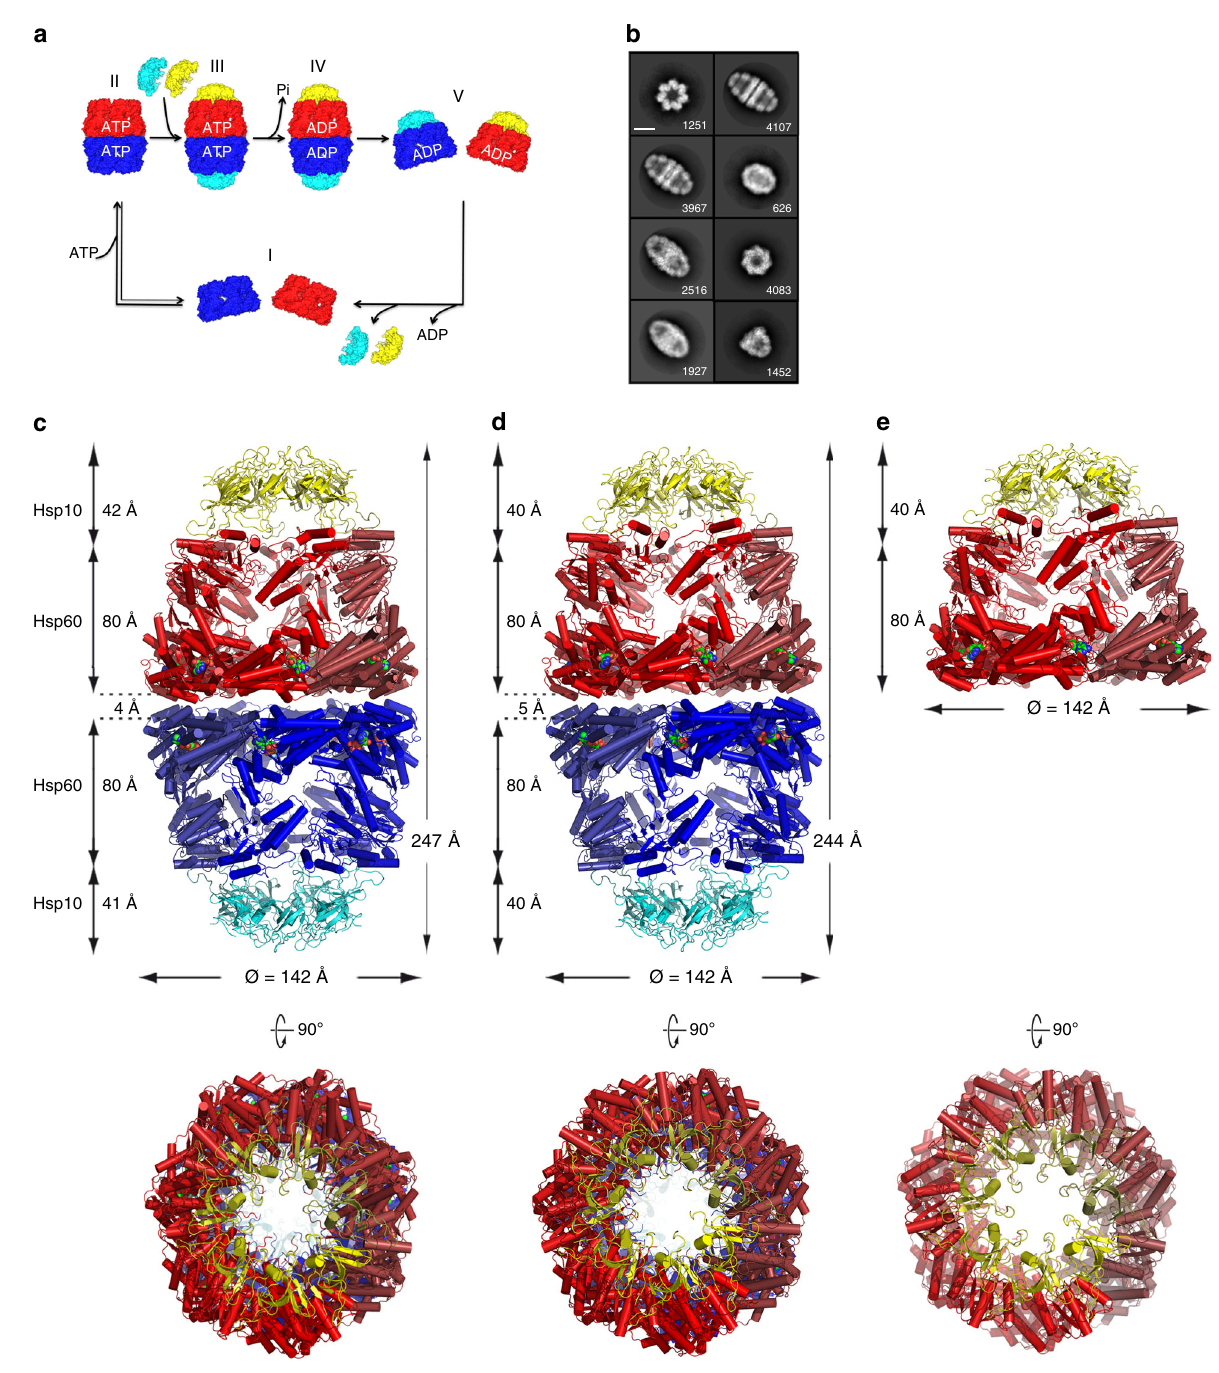
Fig. 1 Structures of mHsp60 – mHsp10 complexes. a Published model for the reaction cycle of mHsp60 – mHsp10 (adapted from ref. 27 ). Red and blue denote mHsp60 heptameric north and south rings, respectively. Yellow and cyan denote mHsp10 heptameric north and south lids, respectively. The same color scheme applies to the remaining fi gure panels. Nucleotide states are labeled. b Selected reference-free 2D class averages of mHsp60 – mHsp10 complexes show detailed structural features. Side views clearly identify football and half-football complexes. In the classes representing front views, the two complexes can be distinguished by taking into account that the footballs have D7 symmetry (top class left column) and the half-footballs C7 symmetry (third class right column). The numbers show the particles per class, and the scale bar represents 100 Å. c Cartoon depiction of the ADP:BeF 3 bound mHsp60 14 – (mHsp10 7 ) 2 football assembly derived from the 3.7 Å resolution crystal structure viewed down a twofold dyad orthogonal to the sevenfold molecular axis. Below is a top view down the sevenfold axis. Individual mHsp60 subunits are colored in graded hues of the relevant color. Spheres depict the nucleotide. d Cartoon depiction of the ADP-bound mHsp60 14 – (mHsp10 7 ) 2 football assembly derived from the 3.08 Å resolution cryo-EM structure. e Cartoon depiction of the ADP-bound mHsp60 7 – mHsp10 7 half-football assembly derived from the 3.83 Å resolution cryo-EM structure. Dimensions of the complexes are, respectively, indicated, using symmetrical C α atoms to de fi ne limiting